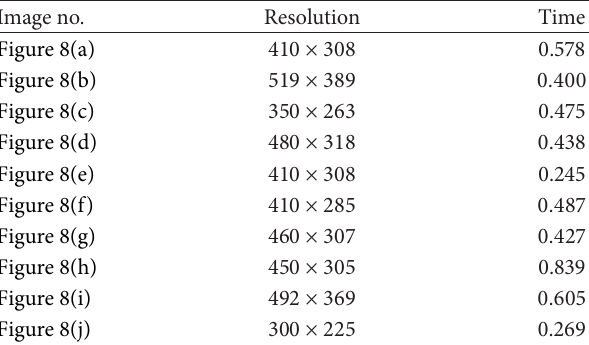
Table 1: Computing cost of the combined algorithm. Image